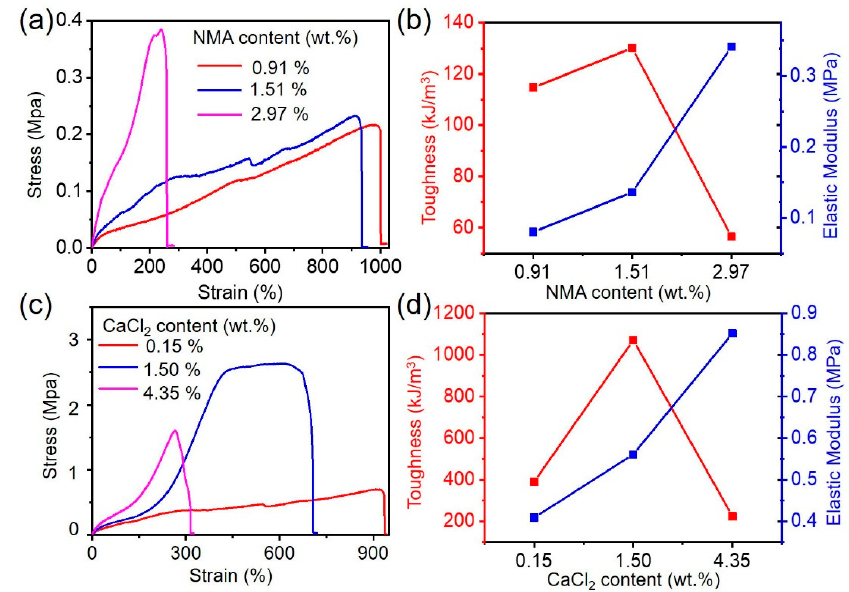
Figure 2. Mechanical properties of CMCS-Ca 2+ /PAAm/PNMA hydrogels. ( a ) The stress–strain be- havior and ( b ) the corresponding toughness and elastic modulus of the CMCS-Ca 2+ /PAAm/PNMA hydrogels as a function of different NMA content; ( c ) the stress–strain behavior and ( d ) the corre- sponding toughness and elastic modulus of the CMCS-Ca 2+ /PAAm/PNMA hydrogels as a function of different addition of CaCl 2